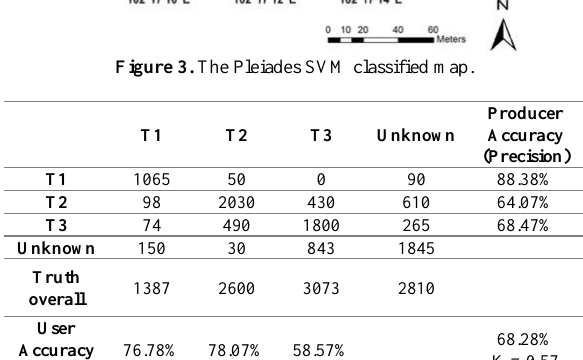
Table 1. Confusion matrix of SVM classification for UAV